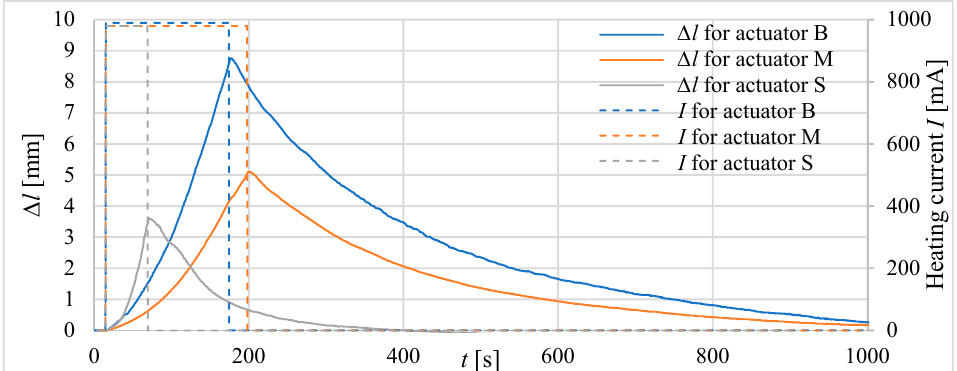
Figure 17. Absolute elongation of the bellow actuators heated to 75 °C.